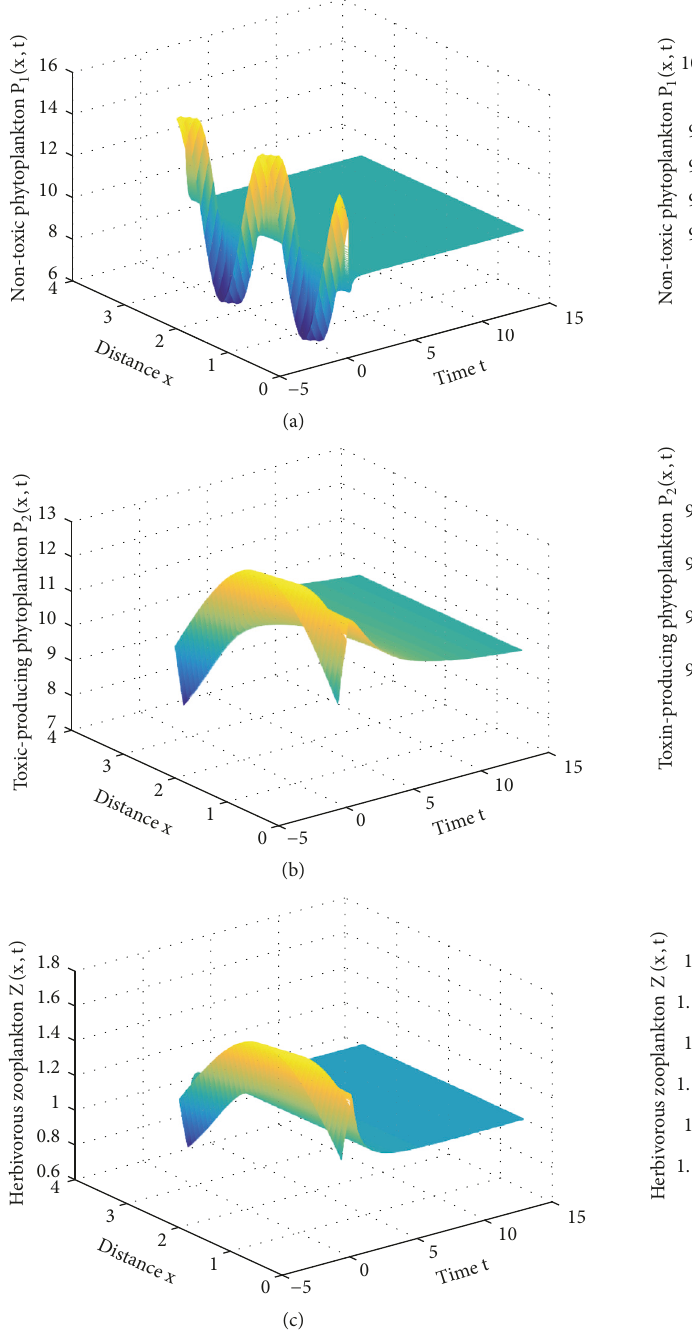
Figure 3: The equilibrium solution 𝐸 ∗ of (3) is asymptotically stable when 𝜏 = 15 < 𝜏 0